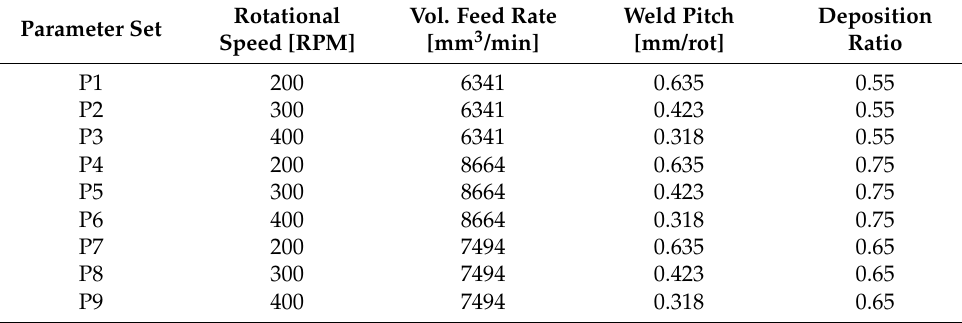
Table 1. Sample set nomenclature and parameter